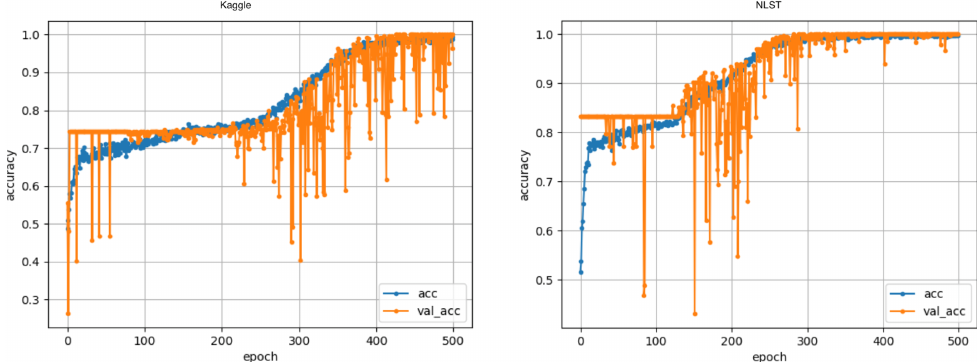
Figure 5. The initial training and validation accuracy for ASEM-CAD with ( left ) Kaggle and ( right ) NLST datasets. The accuracy curves illustrate the ASEM-CAD performance, which is not underfit or overfit with the improvement in validation accuracy over the number of epochs.